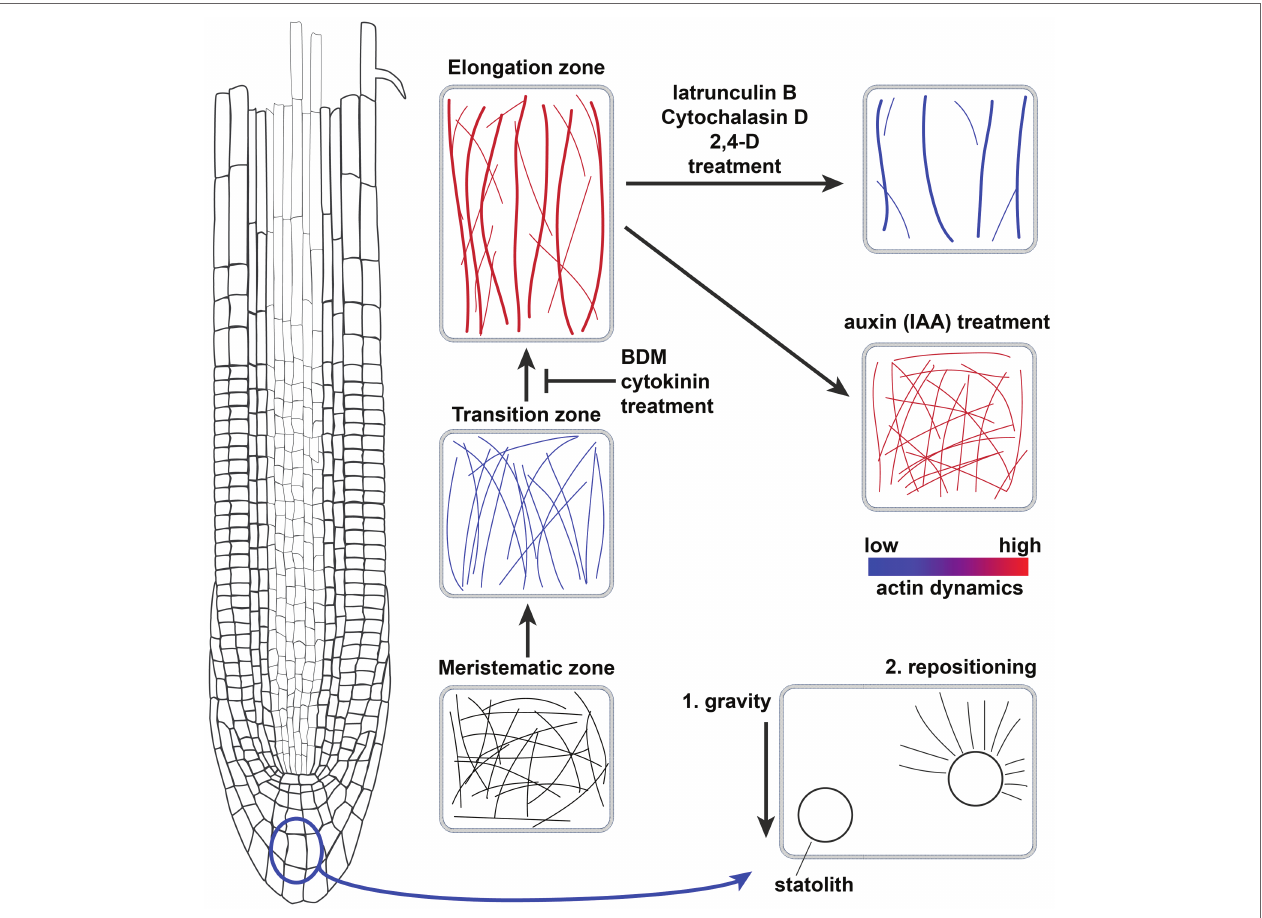
FIGURE 1 | Actin filament network organization in the Arabidopsis thaliana root meristem and the effects of drugs, hormones, and gravity. Schematic representation of the actin filament networks in different cell types of the root meristem and the effect of drugs and hormones on the actin network. Thicker lines equal more bundling of actin filaments, while blue and red coloring denotes actin dynamics. Bottom right cell shows the role of actin filaments in repositioning the gravity-sensing